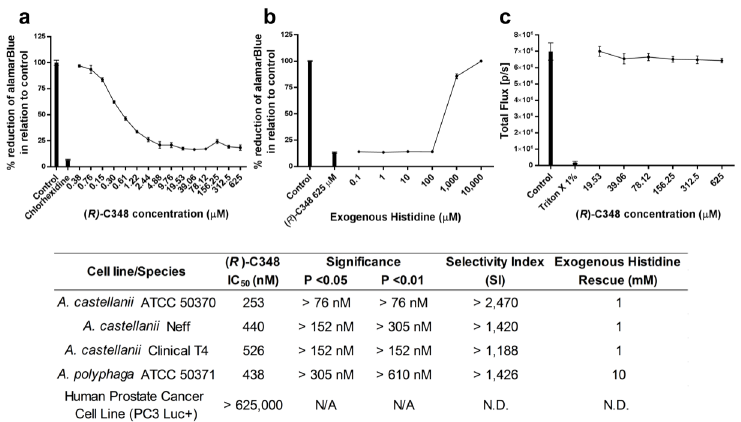
Fig 4. (R)- C348inhibition, rescue and cytotoxicity. Acanthamoeba growth was significantly (P < 0.05) inhibited from 55 nM by ( R )-C348 (a). Through the addition of increasing concentrations of exogenous histidine (end